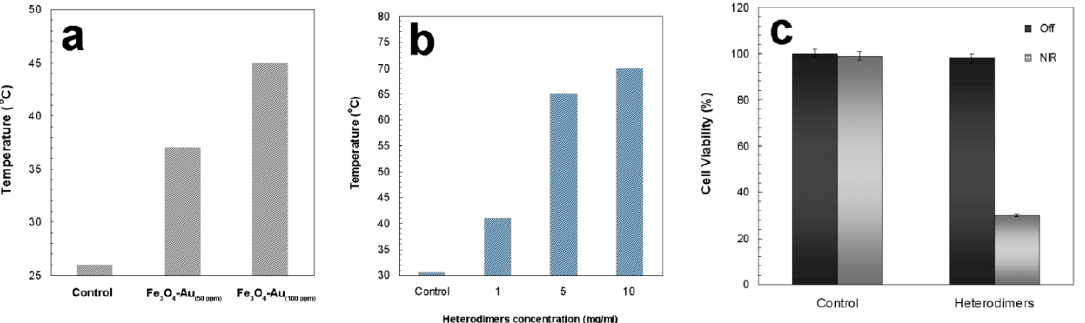
Figure 10. Therapeutic photothermal effects of heterodimers. Photothermal heating of Fe 3 O 4 -Au heterodimers with different Au concentrations under 808 nm near infra-red (NIR) radiation for 300 s ( a ). Data taken from reference [158]. Photothermal heating of Fe 3 O 4 -GQD heterodimers under 808 nm NIR radiation for 300 s ( b ). Data taken from reference [142]. Cell viability of the 4T1 cells with treatment by Fe 3 O 4 -GQD heterodimers under NIR radiation for 3 min ( c ). Data taken from reference [142].